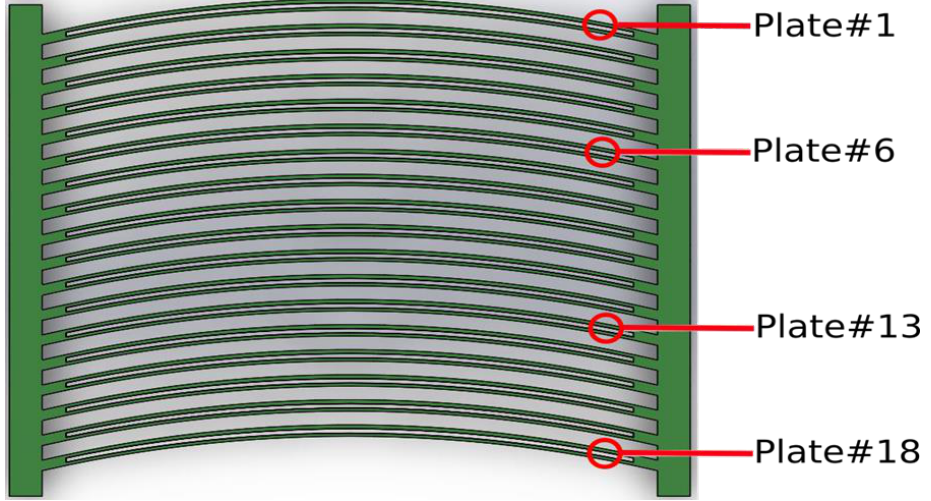
Figure 12. The order in which the fuel plates are arranged within each fuel element of MSTR-HPC. The power output for FP#14 was calculated to be 32,416.06 W, the greatest power output among all fuel plates. 1.62% of the overall power distribution is produced by FP#14. The profile of the power distribution in FP#14 is variable along the fuel plate width, peaking sharply at the edges. This is caused by an increased water-to-fuel ratio locally in areas near the fuel meat edge. The hot channel was found to be located between FP#14 and FP#15 of CR4 for a clean core.